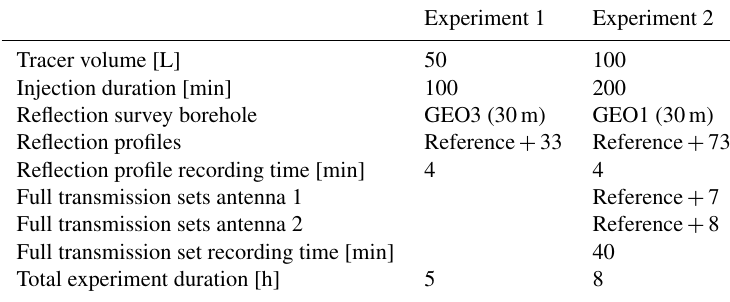
Table 1. Overview on the two tracer experiments and the respective GPR surveys.